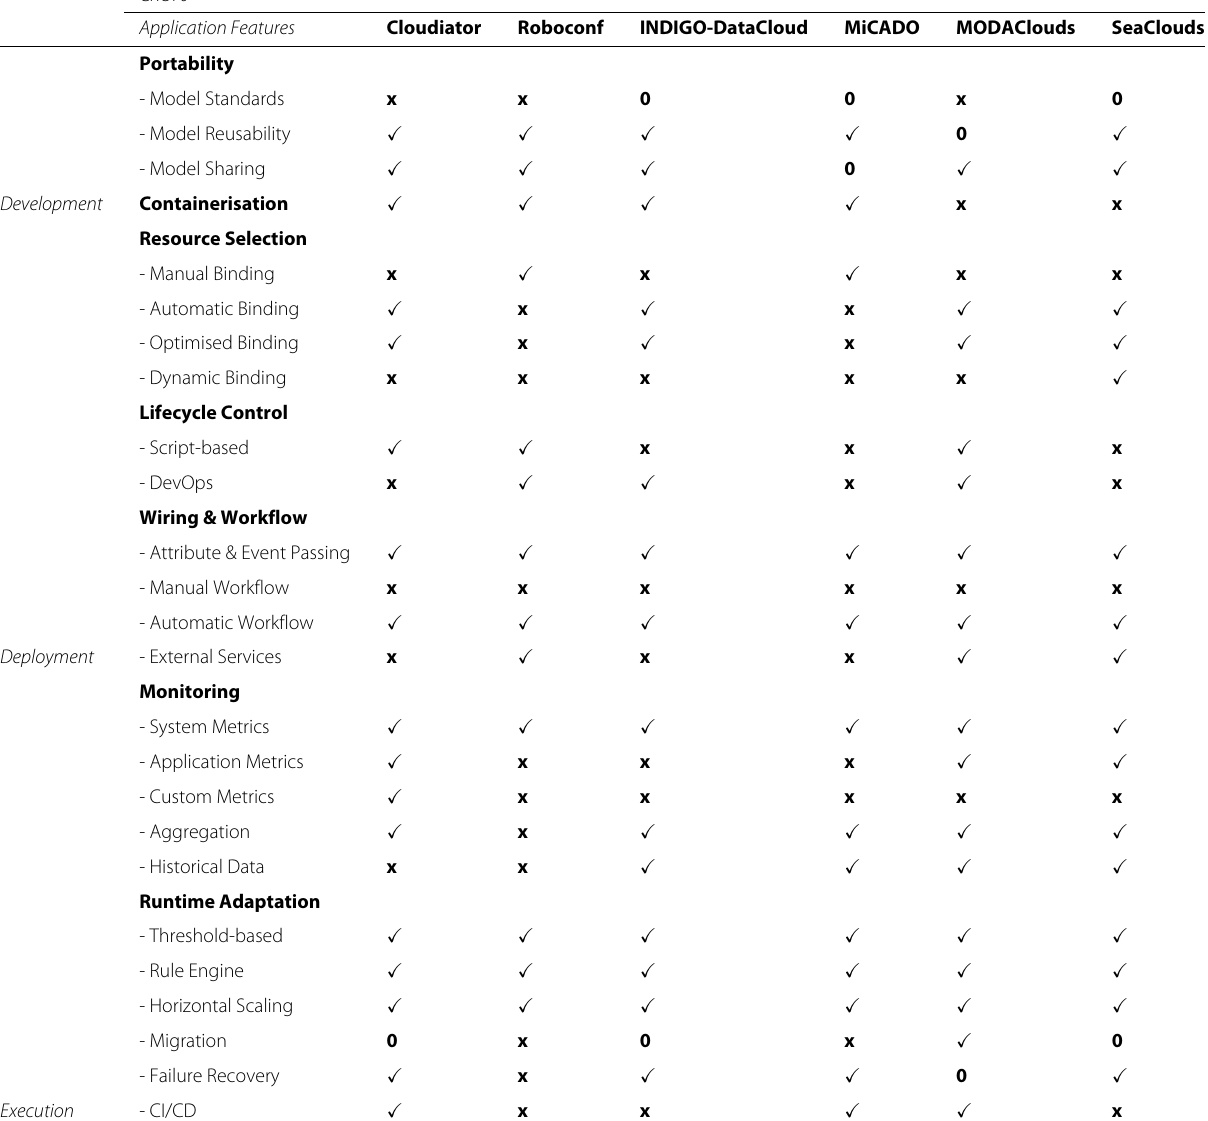
Table 5 Application-based comparison of experimental/research